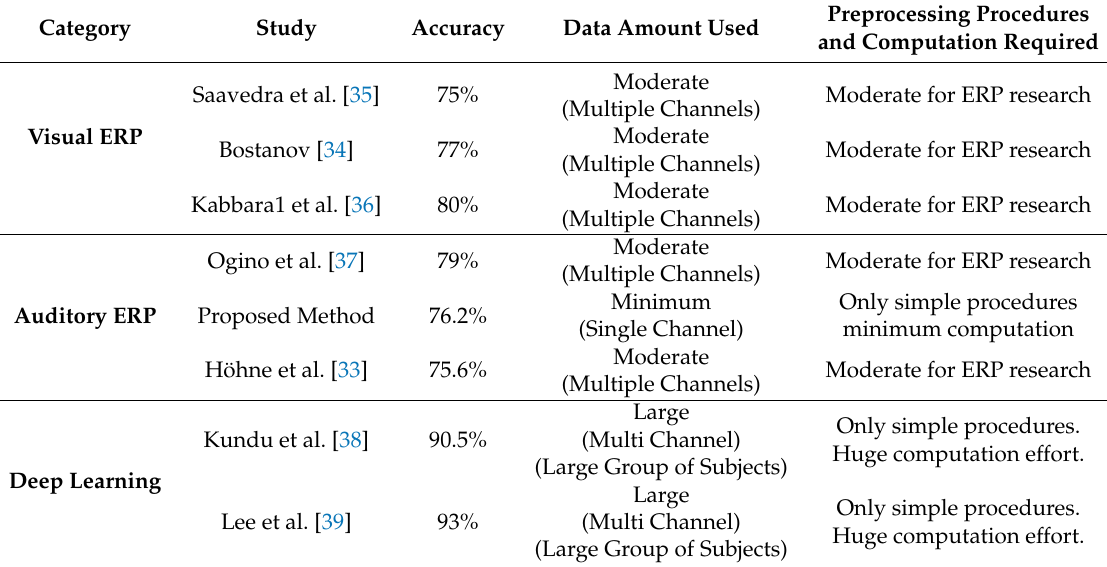
Table 3. State-of-art Study